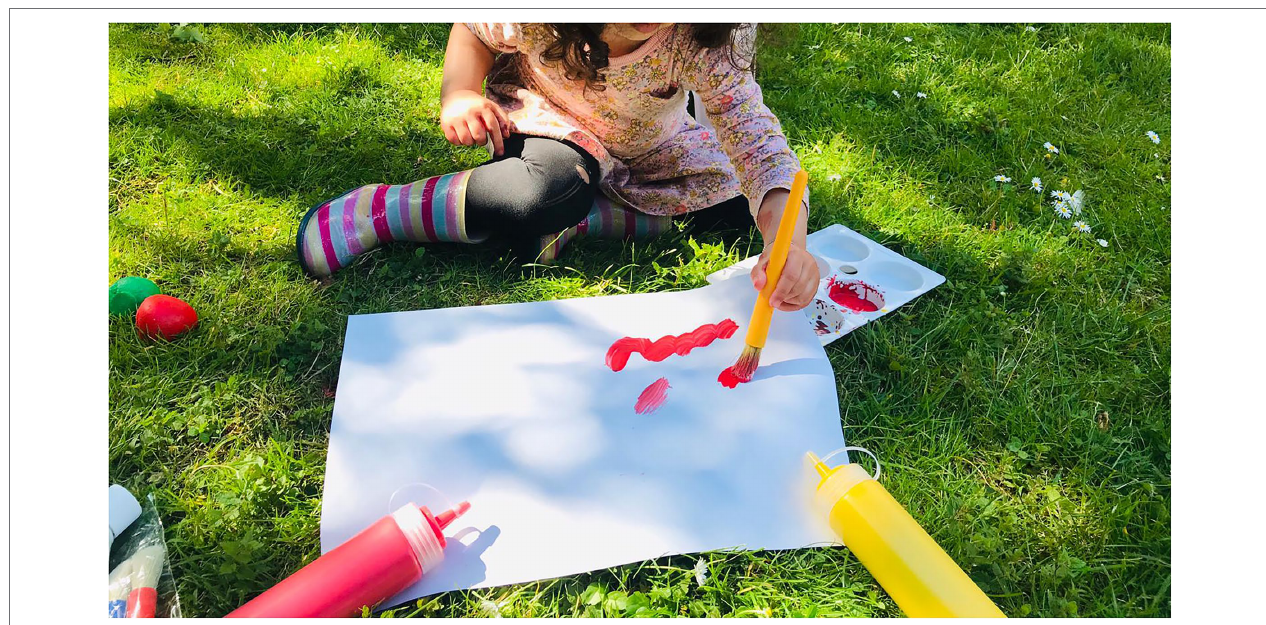
FIGURE 6 | Image shared by parent of infant trying art making (image cropped).